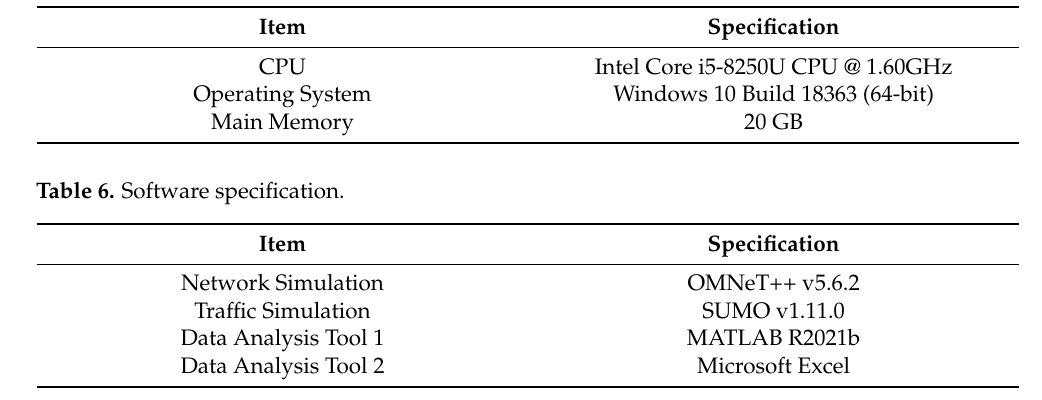
Table 5. Physical host specification.